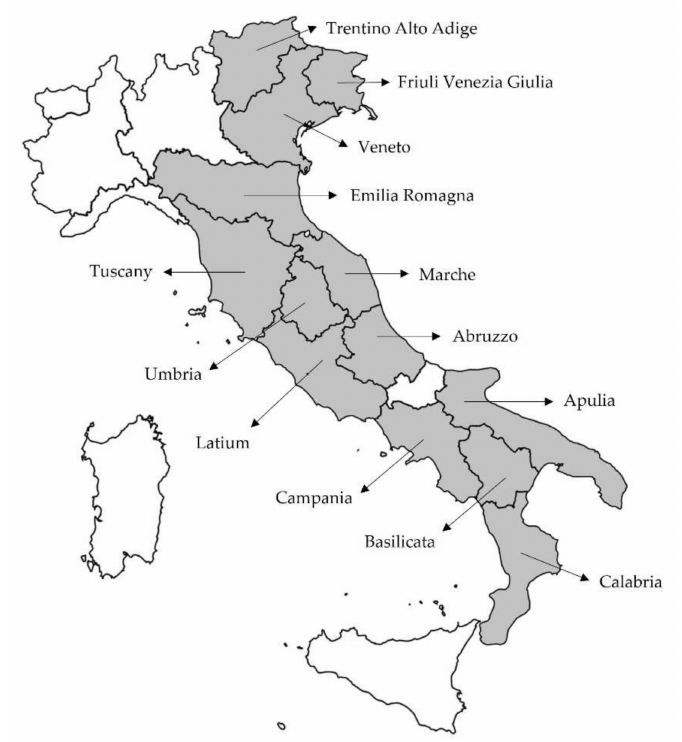
Figure 1. Geographical map of the 13 Italian regions where the putative Sangiovese and Montepul- ciano samples were